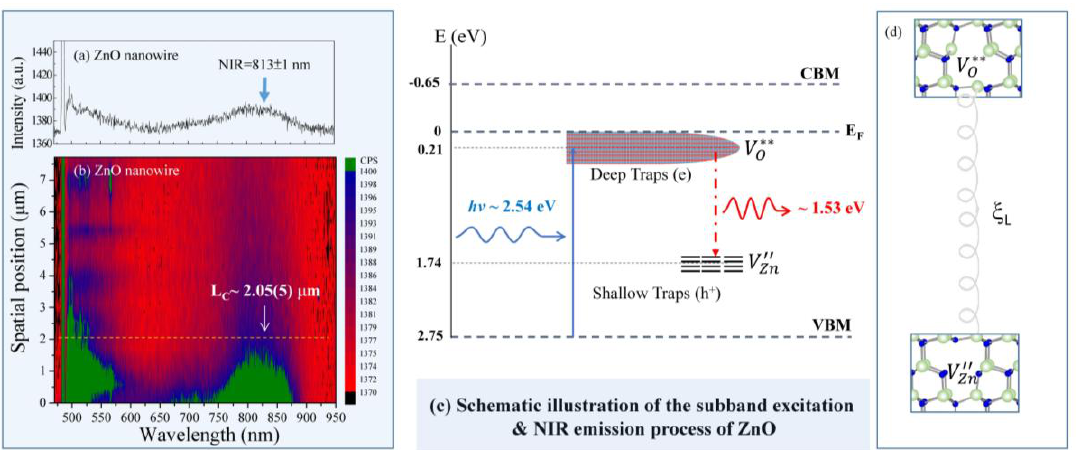
Figure 4. ( a ) Spatial position dependency of room temperature photoluminescence (PL) spectra, revealing a broader near infra-red (NIR) sub-band gap emission; ( b ) 2D plot of PL spectra along a single ZnO NW; ( c ) A schematic plot of the energy levels involved in the NIR luminescence using Kröger-Vink notation; and ( d ) A schematic plot of the local atomic geometry of 𝑉 𝑂∗∗ and 𝑉 𝑍𝑛′′ , respectively, where the mean distance between defects is defined as the correlation length 𝜉 𝐿 .